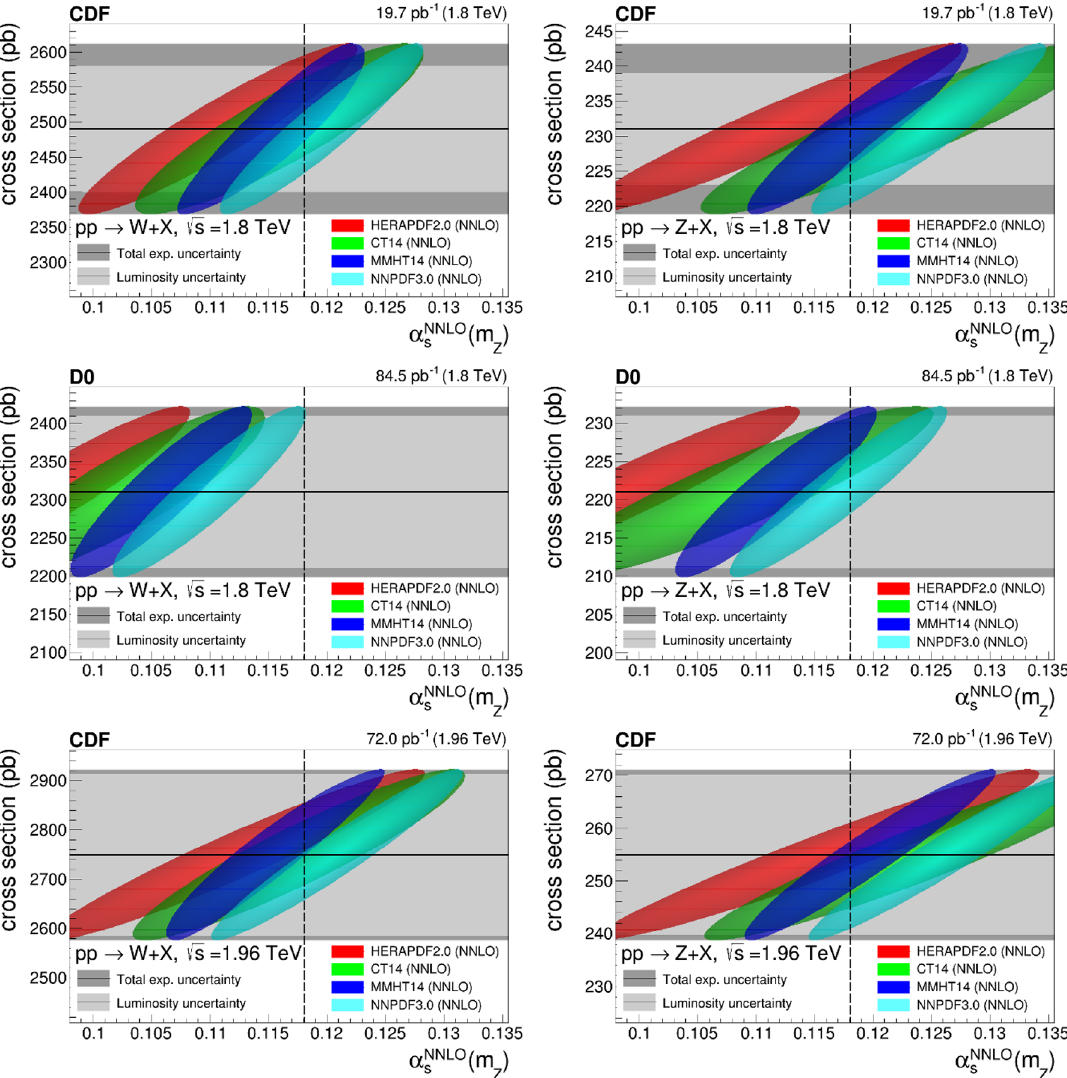
Figure 3 . Same as (cid:12)gure 1 for the production cross sections in pp collisions at the Tevatron of W (cid:6) (CDF, upper left; D0, middle left), and Z (CDF, upper right; D0, middle right) bosons at p s = 1 : 8 TeV, and of W (cid:6) (CDF, bottom left) and Z (CDF, bottom right) bosons at